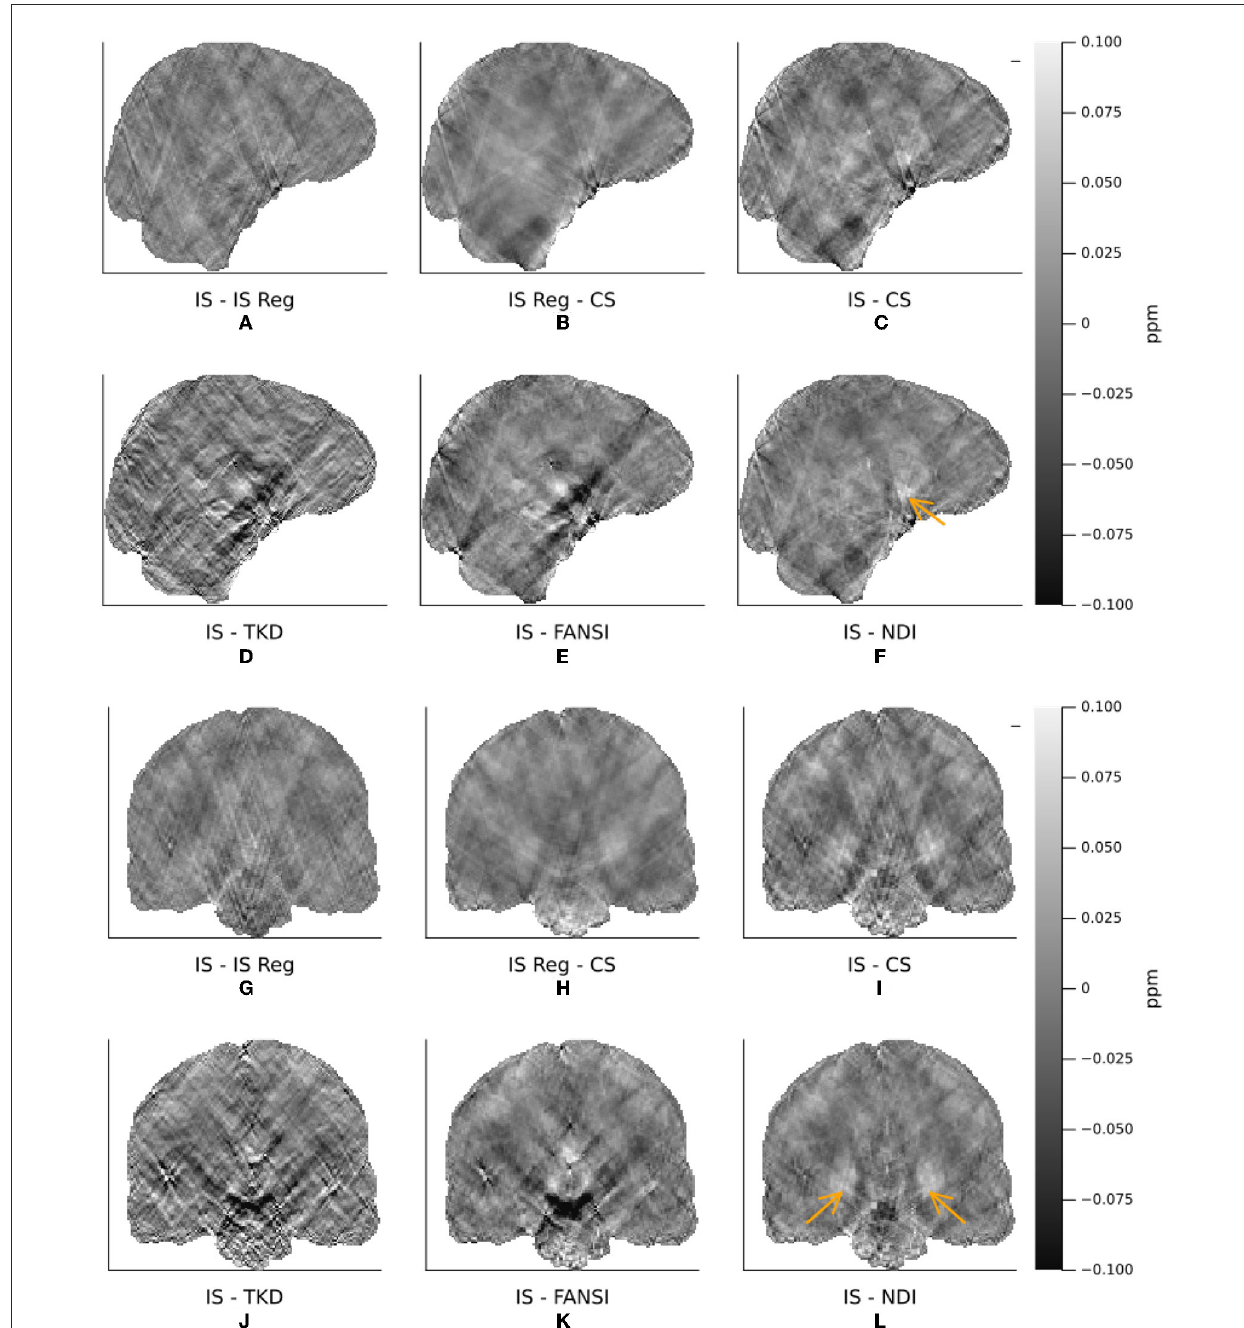
FIGURE8 Differences between incomplete spectrum and conventional QSM reconstructions in the same representative healthy volunteer as shown in Figure 7. The reconstructions are ordered as incomplete spectrum (A, G) , regularized incomplete spectrum (B, H) , compressed sensing (C, I) (top row). Followed by TKD (D, J) , FANSI (E, K) , and NDI (F, L) .